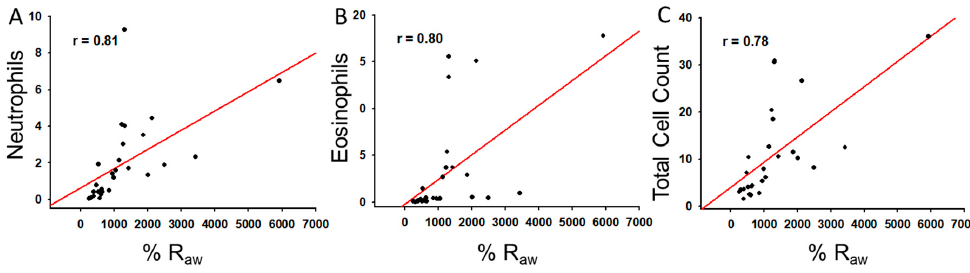
Figure 5. Positive spearman correlations (represented through simple linear regressions graphs) found between %R aw and: ( A ) Eosinophils, ( B ) Neutrophils, ( C ) Total cell count detected in BAL fluid